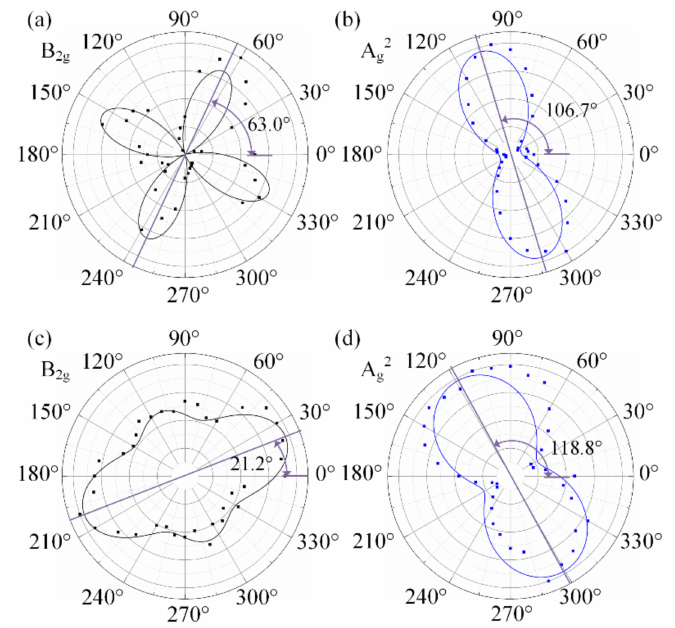
Figure 4. Polar plots of normalized intensities of ( a ) B 2g mode under the PP configuration, ( b ) A g2 mode under the PP configuration, ( c ) B 2g mode under the NA configuration, ( d ) A g2 mode under the NA configuration,